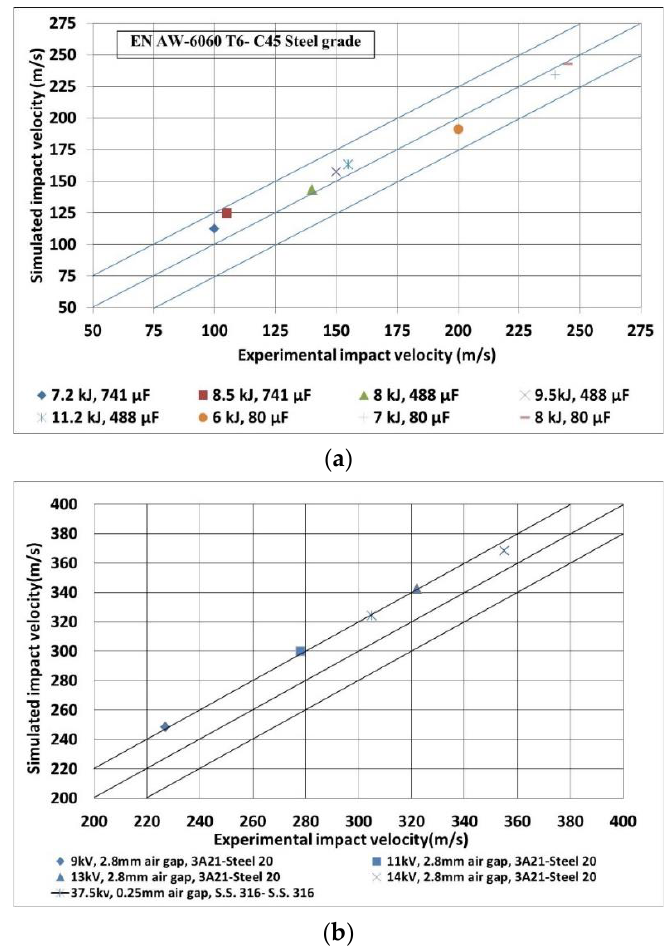
Figure A1. Comparison of experimental and simulated values of workpiece velocity for model validation: Case of compression joining of dissimilar materials ( a ) with variation of input energy and capacitance, data from [51], and ( b ) with variation of input voltage and air gap, data from